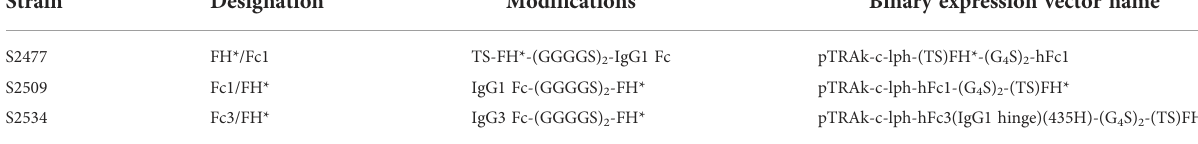
TABLE 1 Description of plant-produced FH*/Fc molecules.